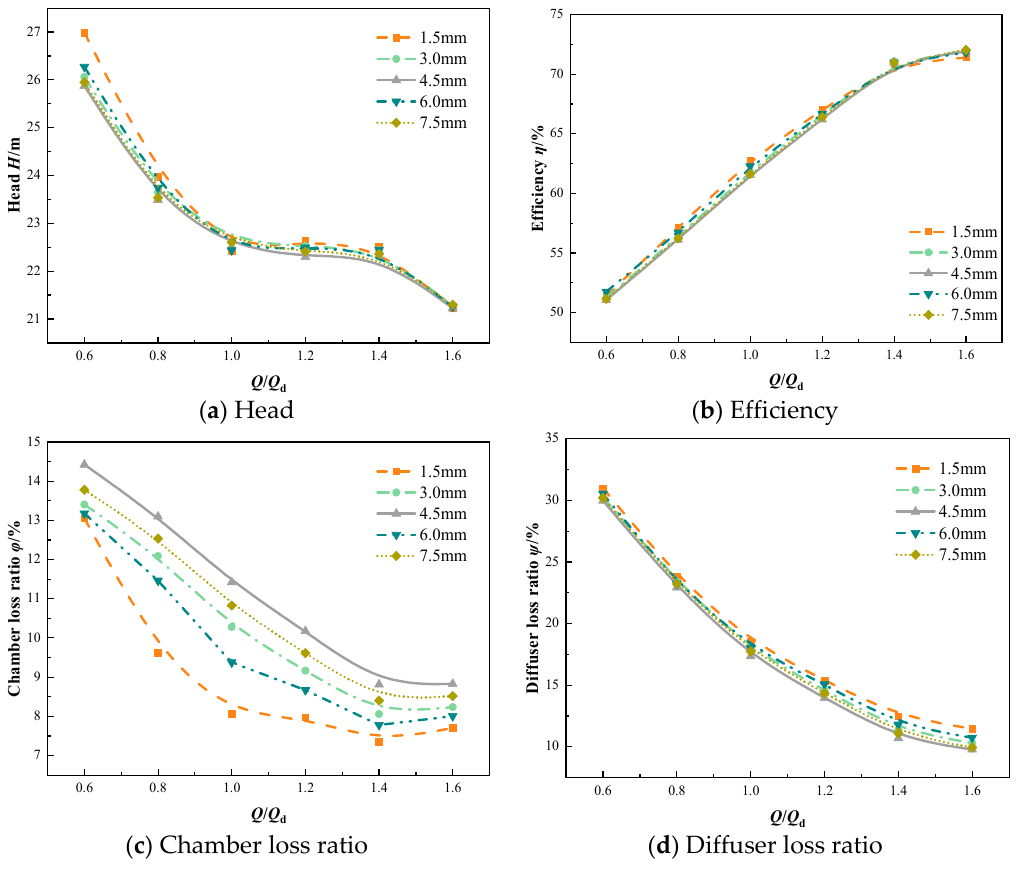
Figure 7. Comparison of performance with different rotor–stator distances.